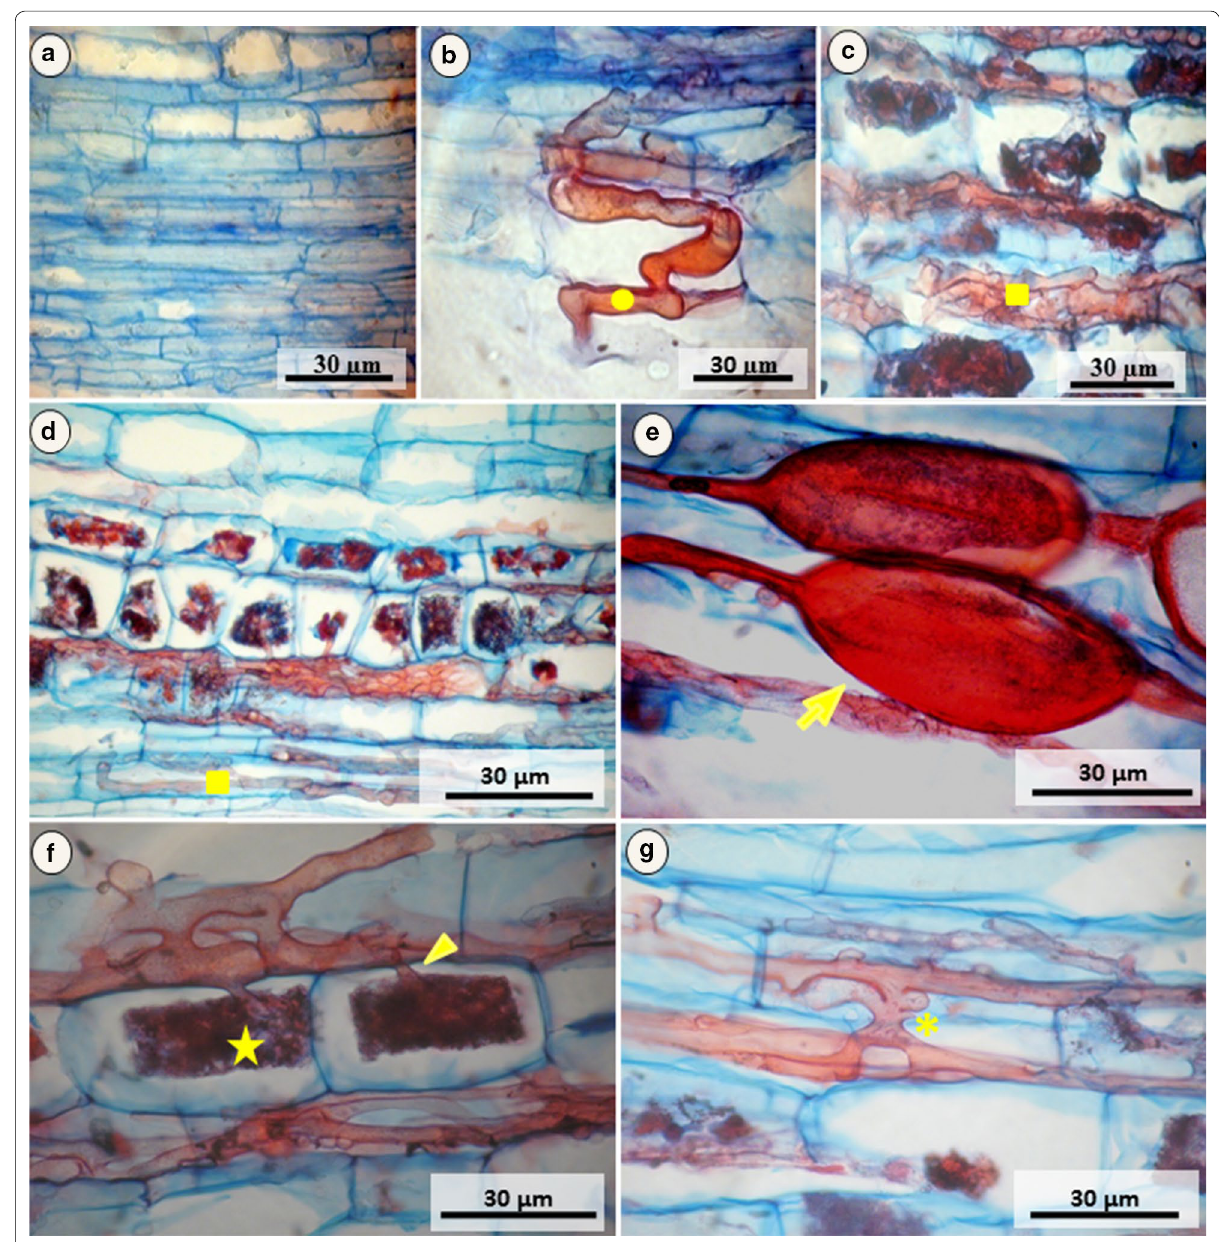
Fig. 1 Longitudinal Section of Piper aduncum root inoculated with mycorrhizal fungi arbuscular (AMFs). a Control sample; b Penetration of hyphae in epidermal cells with formation of hyphopodium in 30 dpi; c Intense colonization in 60 dpi; d Colonization in 90 dpi; e Formation of vesicles in 90 dpi; f Hyphae inter- and intracellularly and formation of arbuscules in 90 dpi; g Hepatic anastomosis in 90 dpi; (Filled circle) Hyphopodium; (Filled square) Intracellular hyphae; ( ) Vesicles; ( ★ ) Arbuscules; (Filled triangle) Arbuscular trunks; ( ) Hyphatic